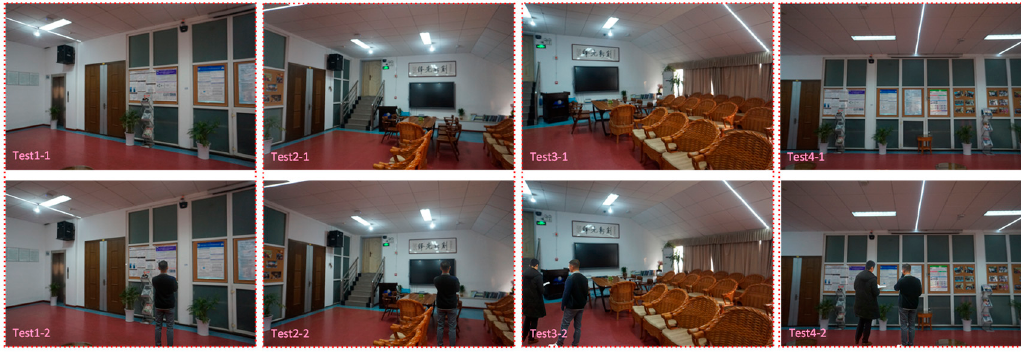
Figure 19. Four control group positioning images.